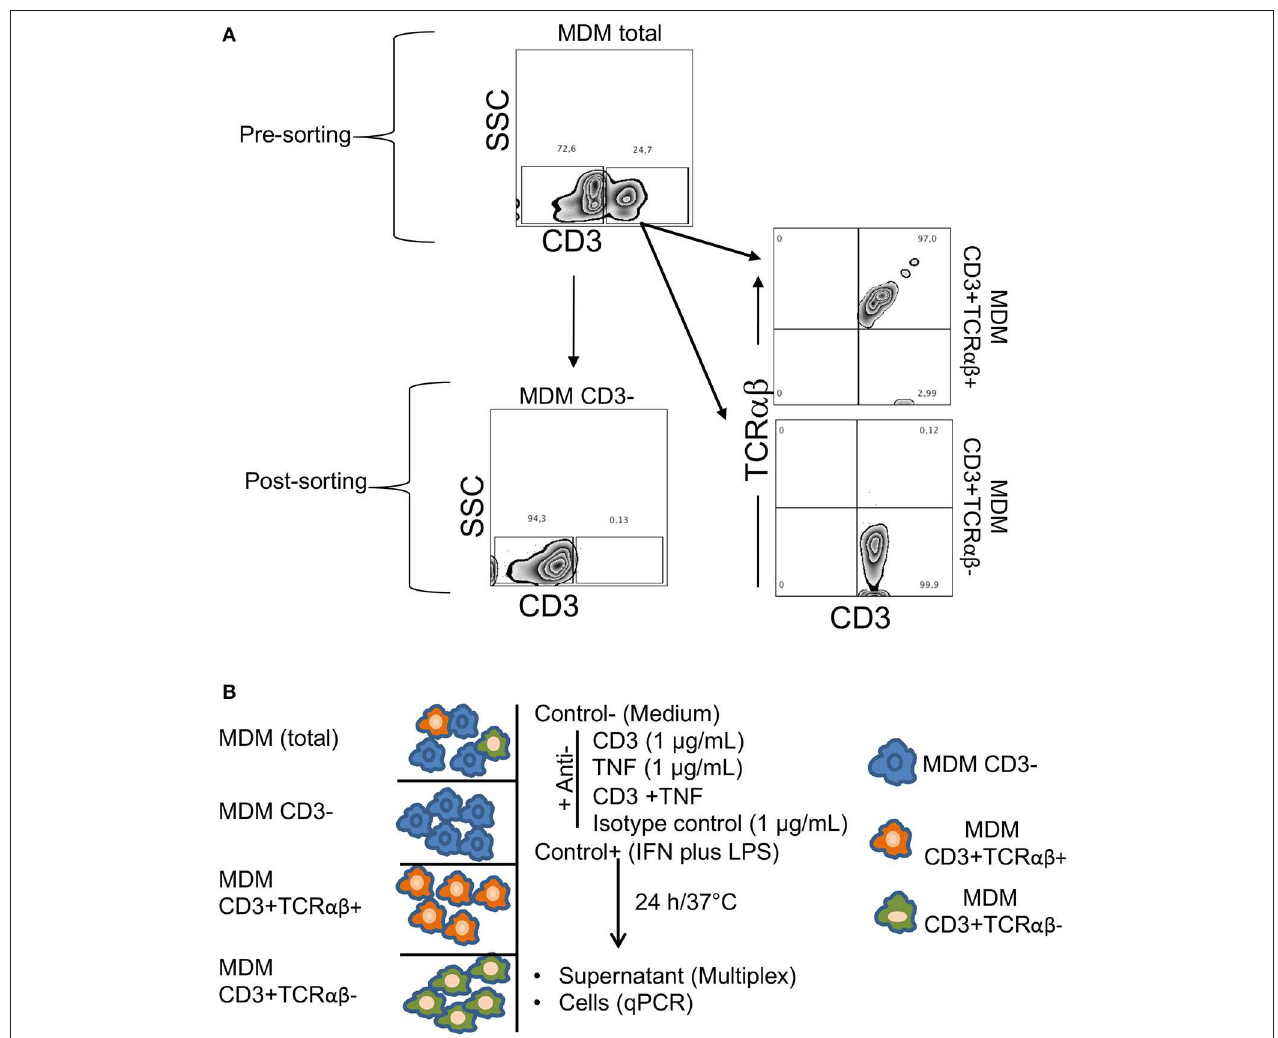
FIGURE 6 | Sorting of CD3 + TCR αβ − and CD3 + TCR αβ + MDM using flow cytometry and an experimental strategy. Human MDM were obtained after 7 days in culture, and the cells were prepared to sort CD3 + TCR αβ + , CD3 + TCR αβ − and CD3 − MDM by flow cytometry. (A) Representative zebra plot corresponding to total MDM before (up) and after (down, left, and right) sorting. Using adequate controls, the gates were delimited to obtain MDM subpopulations, and our data showed that after sorting, we obtained at least 90% of the enriched cell subpopulation. The data are representative of six independent donors. (B) Our experimental design consisted of total and purified MDM cultured and stimulated by anti-CD3 (1 µ g/mL), anti-TNF (1 µ g/mL), anti-CD3 plus anti-TNF (1 µ g/mL each-one) antibodies, isotype control (IgG1) antibody, negative control without stimuli (medium) and a positive control of cell activation (LPS 100ng/mL plus IFN- γ 20ng/mL), 24h in culture under humid conditions (37 ◦ C and 5%CO 2 ). The supernatant was recovered to measure cytokines and chemokines with Luminex technology, and the cells were recovered to evaluate the gen level expression of the suppressor of cytokine signaling 3 (SOCS3) by